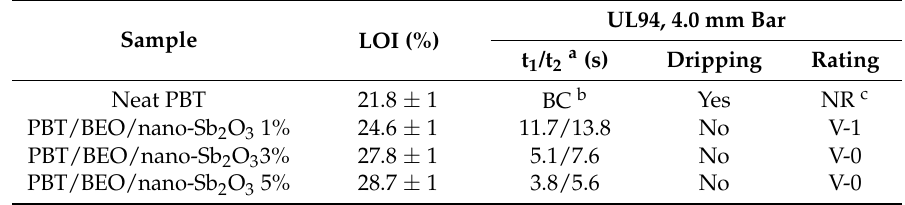
Table 7. Results of the limiting oxygen index (LOI) and UL-94 tests for the neat PBT and its